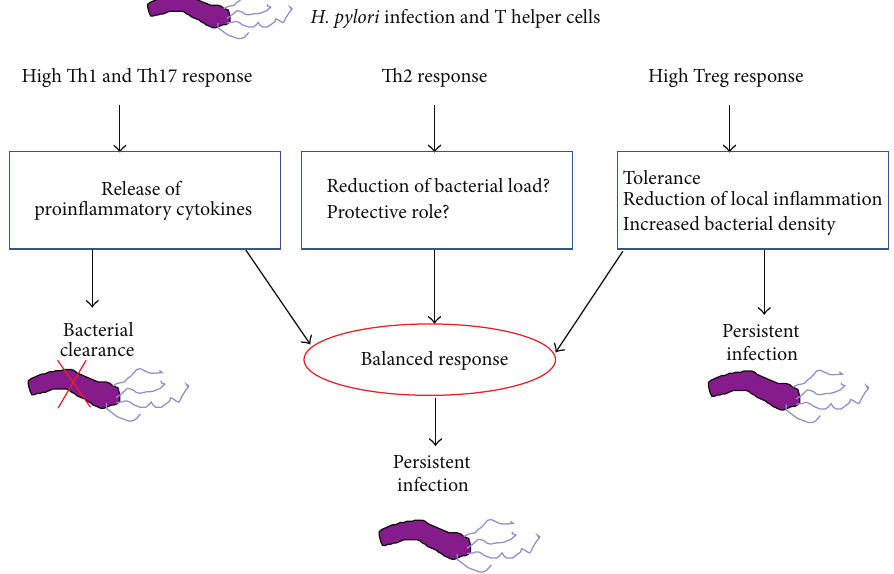
Figure 3: The interplay between H. pylori and the effective T helper lymphocytes. Although Th1 and Th17 pathways are both responsible for promoting inflammatory activities during H. pylori infection, neither Th1 nor Th17 cells are by themselves capable of a spontaneous clearance of the infection. It could be due to an impaired release of cytokines, suggesting that a more pronounced inflammation during the early phase of infection could switch the events towards eradication. Th2 response has been implicated in reducing bacterial load but its protective role is still controversial and deserves further investigation. Treg cells limit local inflammation and tissue damage but at the same time this fact favours a tolerogenic status which leads to a persistent infection. This complex interplay suggests that the conflict between persistent infection and clearance is decided in the early phase of infection.